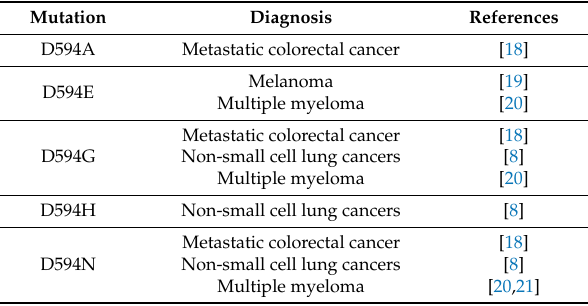
Figure 2. The classification of BRAF mutations and their signaling pathways. Class I is related to codon 600. BRAF V600 (BRAF Mut) acts as a monomer in an RAS-independent manner (RAS WT) and constitutively activate extracellular signal-regulated kinases (ERK) by phosphorylation. In class II signal transduction involves non-V600 mutant. Strong kinase activation is regulated by dimers of mutant BRAF (BRAF Mut), independently of RAS (RAS WT). Class III is kinase-impaired and consists of BRAF non-600 mutant (BRAF Mut) and CRAF wild type (CRAF WT) as a heterodimer. The signal is transferred downstream in the presents of RAS mutant (RAS Mut). Table 1. BRAF D594 mutation in di ff erent type of cancers found in literature.